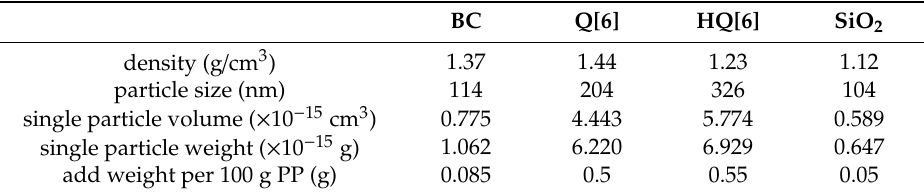
Table 1. Parameters of nucleating agents.